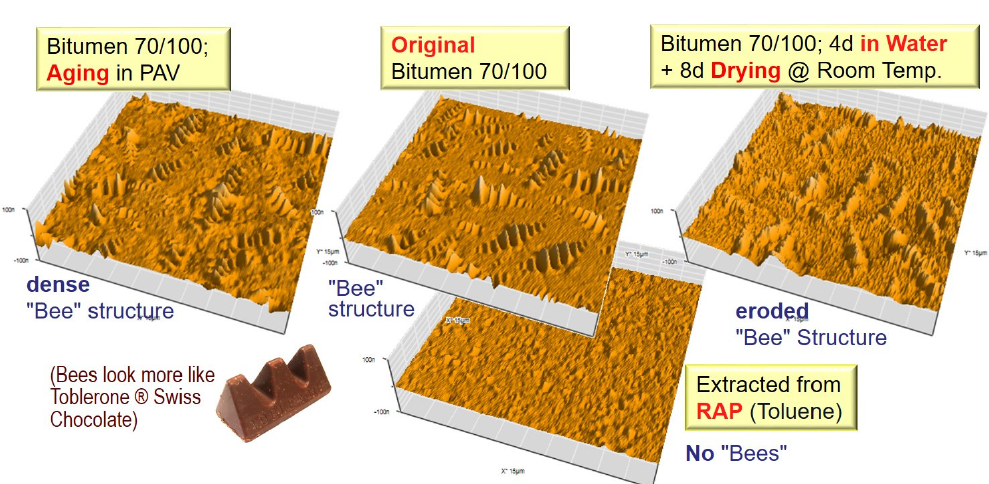
Figure 1. Basic asphalt material concepts.